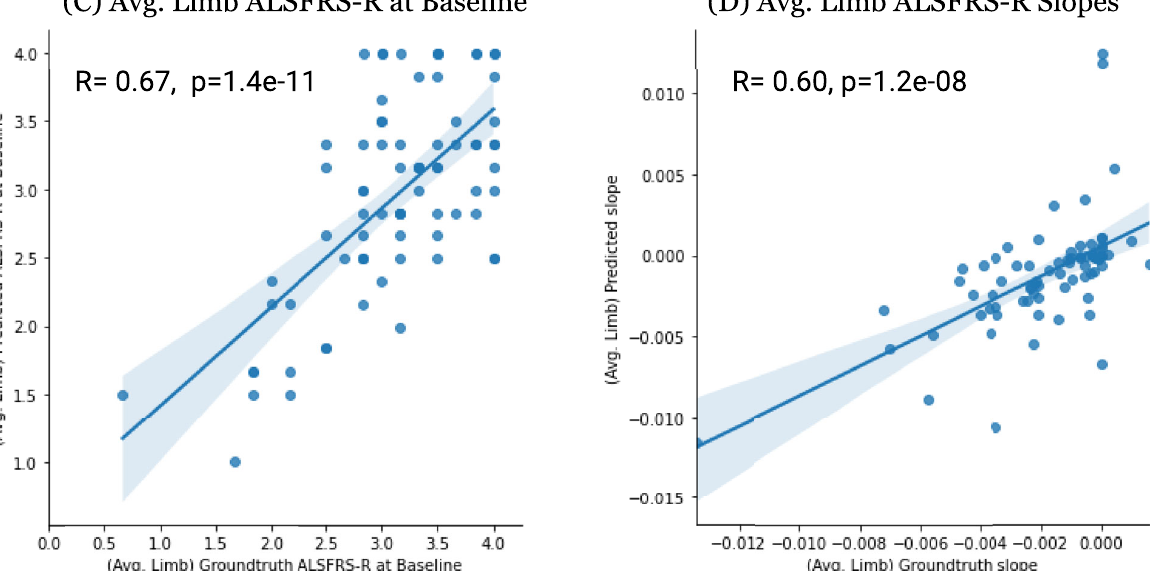
Fig. 2 Plots depicting correlation of ALSFRS-R scores at baseline (PMP enrollment) and correlation of slopes over time on the 109 test participants. The plots depict pearson correlation between ground-truth and predicted scores based on A speech ALSFRS-R scores at baseline, B slopes over time from ALSFRS-R speech scores, C limb ALSFRS-R scores (averaged over 6 limb-based movements) at baseline, and D slopes over time from averaged limb-movement scores. The x -axis in the sub fi gures denotes the ground-truth values, and the y -axis denotes the predicted values. Sub fi gures A and B for speech include scores on 90 participants, sub fi gures C and D for limb show scores on 83 performing models, using the voice CNN model and accelerometer limb functions at baseline is 0.67. The correlation of the slopes for (FFT 1 Hz MLP multi-label) model. Confusion matrices for these two the speech scores is 0.68 (Fig. 2B) and is 0.60 for the slopes from models ’ predictions are presented in Supplementary Table 1a and the limb scores (Fig. 2D). Not surprisingly, the correlation of the b. The voice CNN model, evaluated on 1333 samples from 90 test slopes computed over time from the ground-truth and predicted participants, attained the highest AUC (0.86 [CI:0.85-0.88]). For the values is lower for both models compared to the correlations of limb related functions, the MLP multi-label FFT-1Hz model the raw scores at just the baseline which is just a single point in evaluated on 3833 accelerometer samples from 83 test participants time. performed best, with an AUC between 0.70 – 0.75 on 5 of the 6 limb Table 2 presents ROC-AUC values with bootstrapped con fi dence related functions, with the lowest performance for handwriting intervals for the predicted ALSFRS-R scores for speech, 6 limb- (AUC = 0.64). Somewhat surprisingly, the accelerometer model related functions, and the 3 respiratory functions for our best